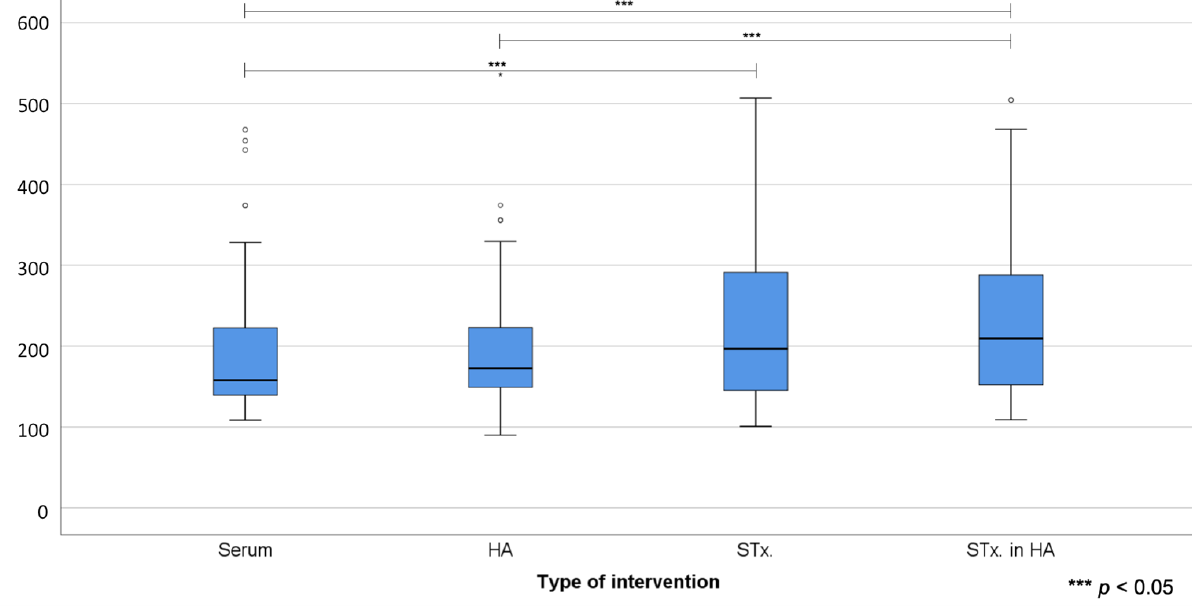
Figure 2. Boxplot analysis showing the underlying distribution of final cartilage thickness vs. the four treatment groups. Circles represent outliers with more than 1.5 times interquartile range. Significant group differences are marked (***).